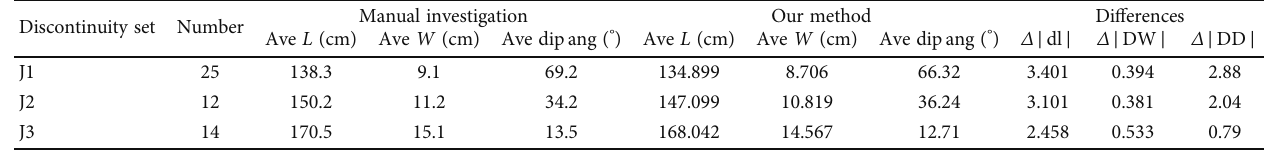
Table 2: Geometry parameters obtained by the proposed